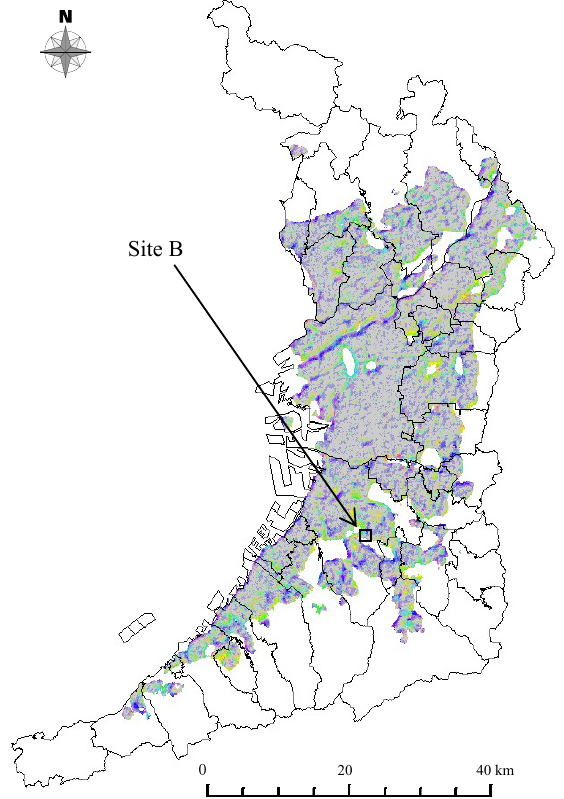
Figure 11 . Spatial variation map of local population dynamics between 1995 and 2015. The legend is shown in Figure